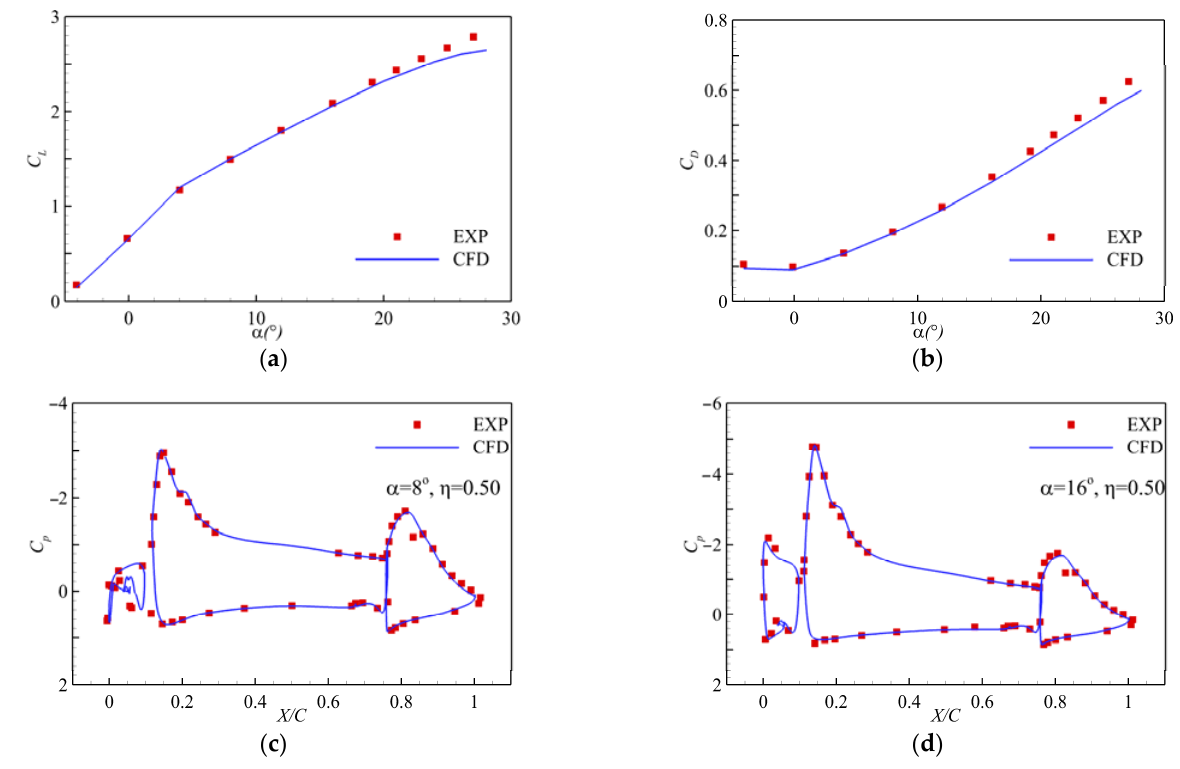
Figure 4. Comparison results of the experiment and CFD calculation of NASA Trap ‐ wing Config ‐ uration 8 for Ma = 0.2, Re = 4.3 × 10 6 : ( a ) Lift curve; ( b ) Drag curve; ( c ) C p comparison, α = 8°; ( d ) C p comparison, α = 16°.